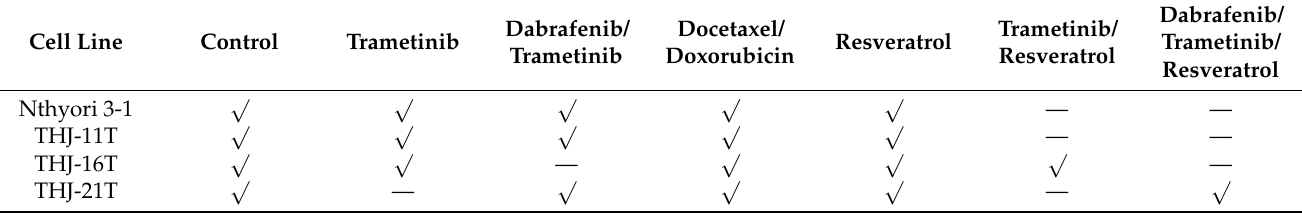
Table 1. Drug treatments for Nthyori 3-1, THJ-11T, THJ-16T, and THJ-21T cell